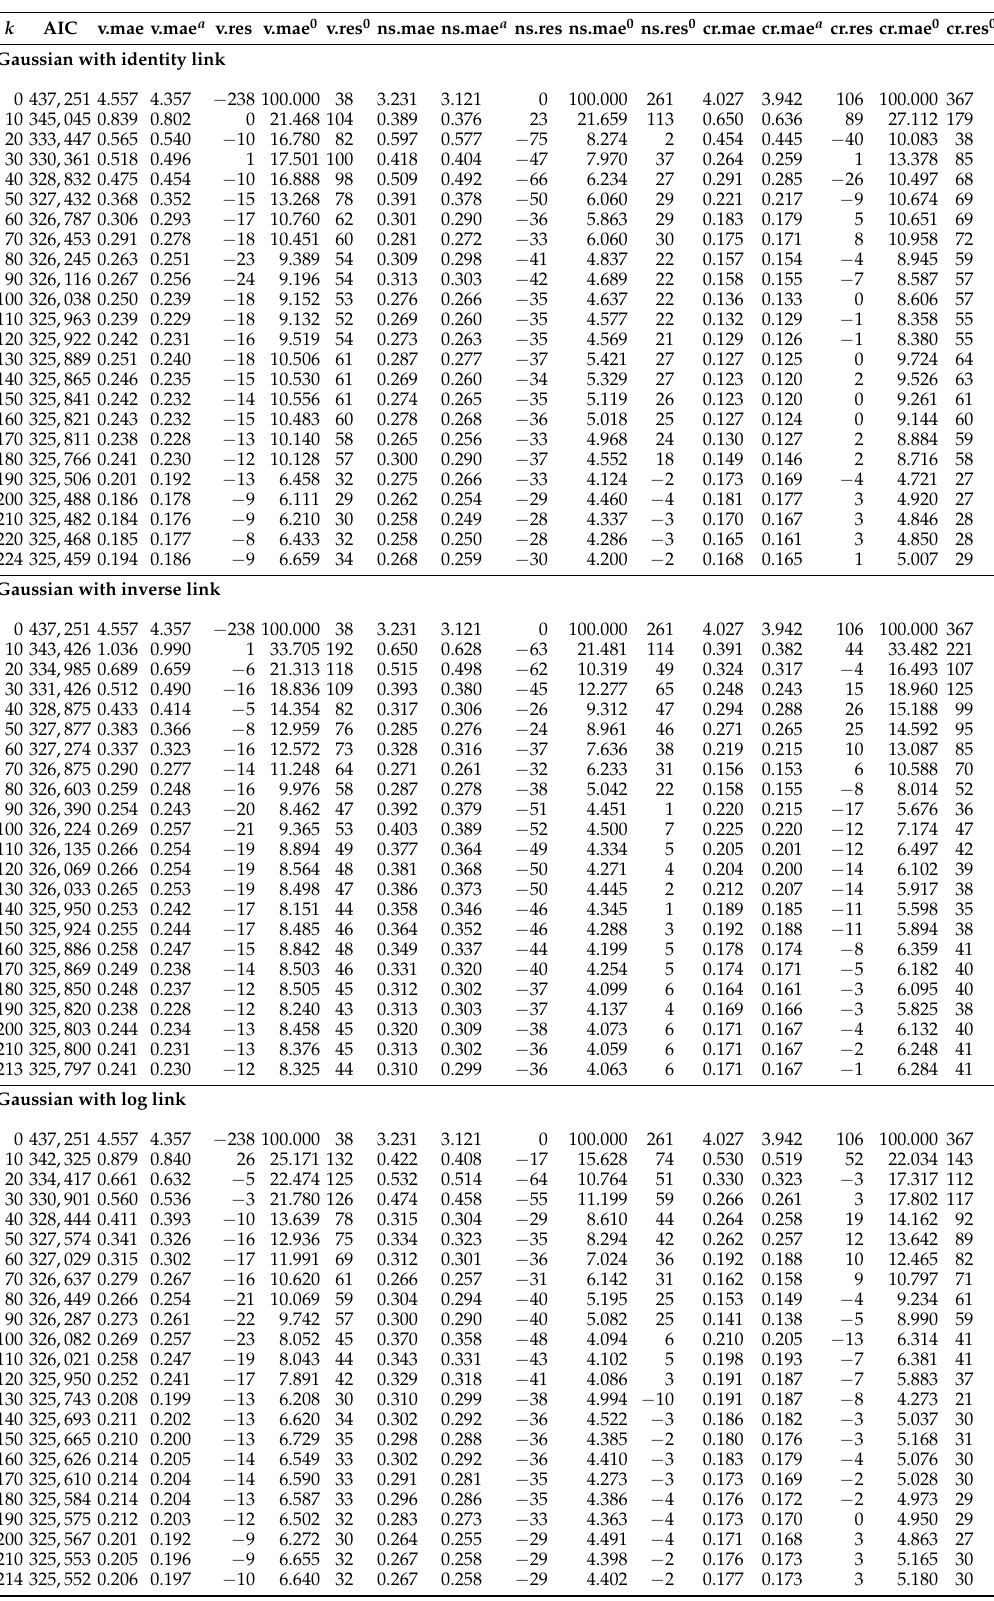
Table A11. AIC scores and out-of-sample validation figures of the gaussian GLMs of BEL with identity, inverse and log link functions under 300–886 after each tenth and the final iteration.